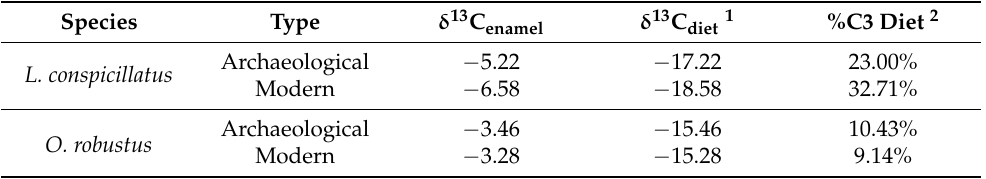
Table 3. δ 13 C enamel , δ 13 C diet and %C3 diet for archaeological and modern taxa. Species Species Type δ 13 C enamel δ 13 C diet 1 %C3 Diet 2